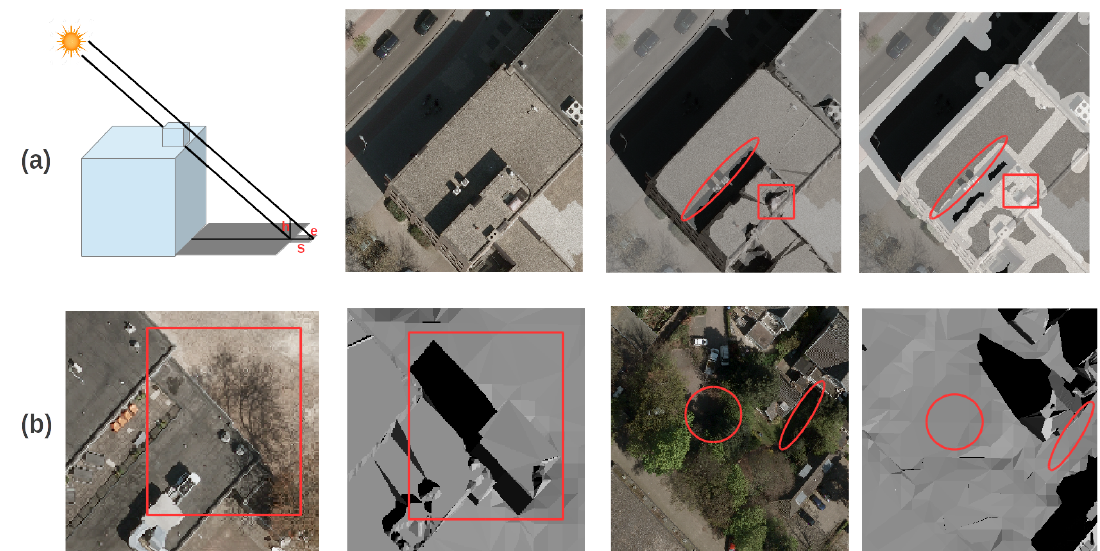
Figure 4. ( a ) The left image shows how the size of the adaptive erosion filtering element is calculated from the height of detail and the elevation angle of the sun. The middle two images show the VHR image and reconstructed shadows from a 3D model. The square and circle indicate shadow and non-shadow mislabels. The right image shows that mislabels are reduced by filtering. Shadow, non-shadow, and filtered samples are shown in black, gray, and white, respectively. ( b ) The left two images show a case where a building is removed after the 3D model was acquired. This introduces mislabeled shadow samples. The right two images show that a 3D model with omitted trees introduces mislabels in non-shadow